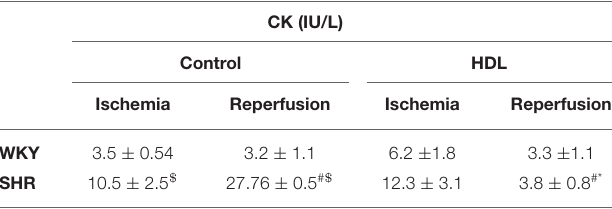
TABLE 2 | Effect of chronic HDL treatment on creatine kinase release in response to I/R injury.